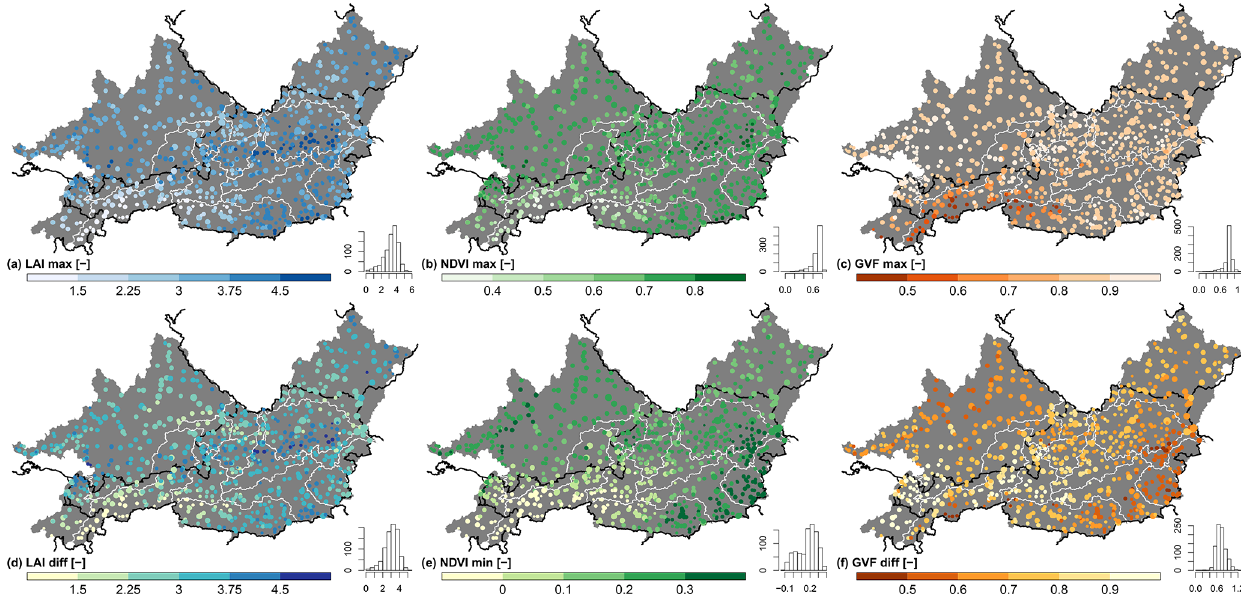
Figure 9. Spatial distribution of vegetation indices representing the characteristics of the entire topographic catchment (basin delineation A, Fig. 2a). The histograms indicate the number of basins (out of 859) in each category. The size of the circles is proportional to the catchment area. © EuroGeographics for the administrative